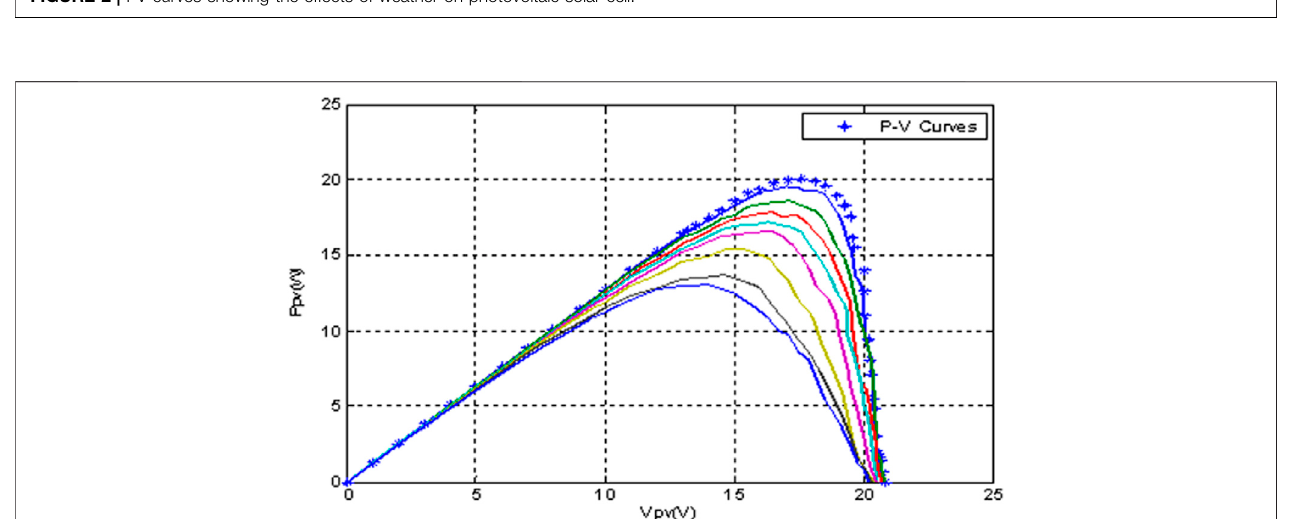
FIGURE 2 | I-V curves showing the effects of weather on photovoltaic solar cell.